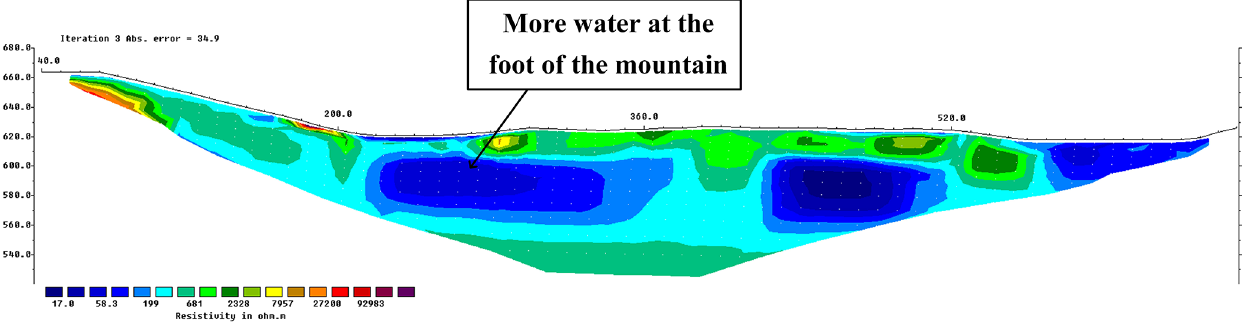
Figure 16. Profile view of survey line L2 obtained using the high-density electrical method.